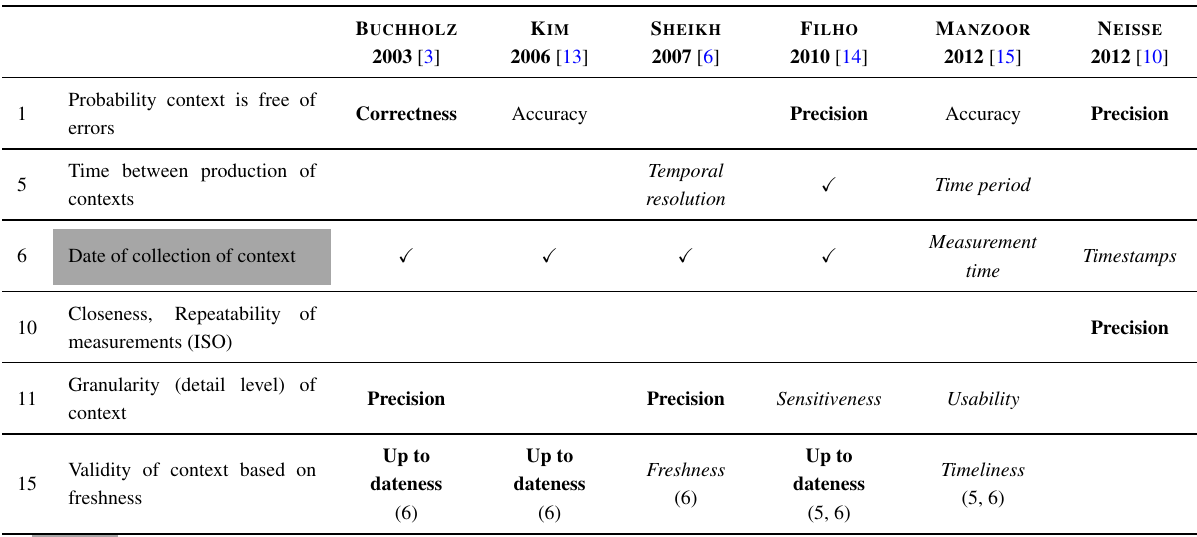
Table 2. Extract of the comparison of different lists of QoC criteria